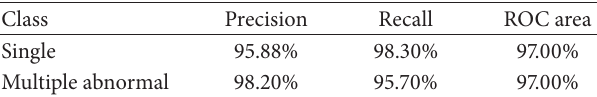
Table7:Resultof10-foldcross-validationofproposedmethodology on [6] data set over 10 MHI